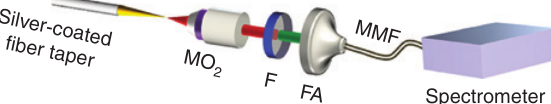
Figure 6: Experimental setup for nanofocusing characteristic examination of the Ag-coated fiber